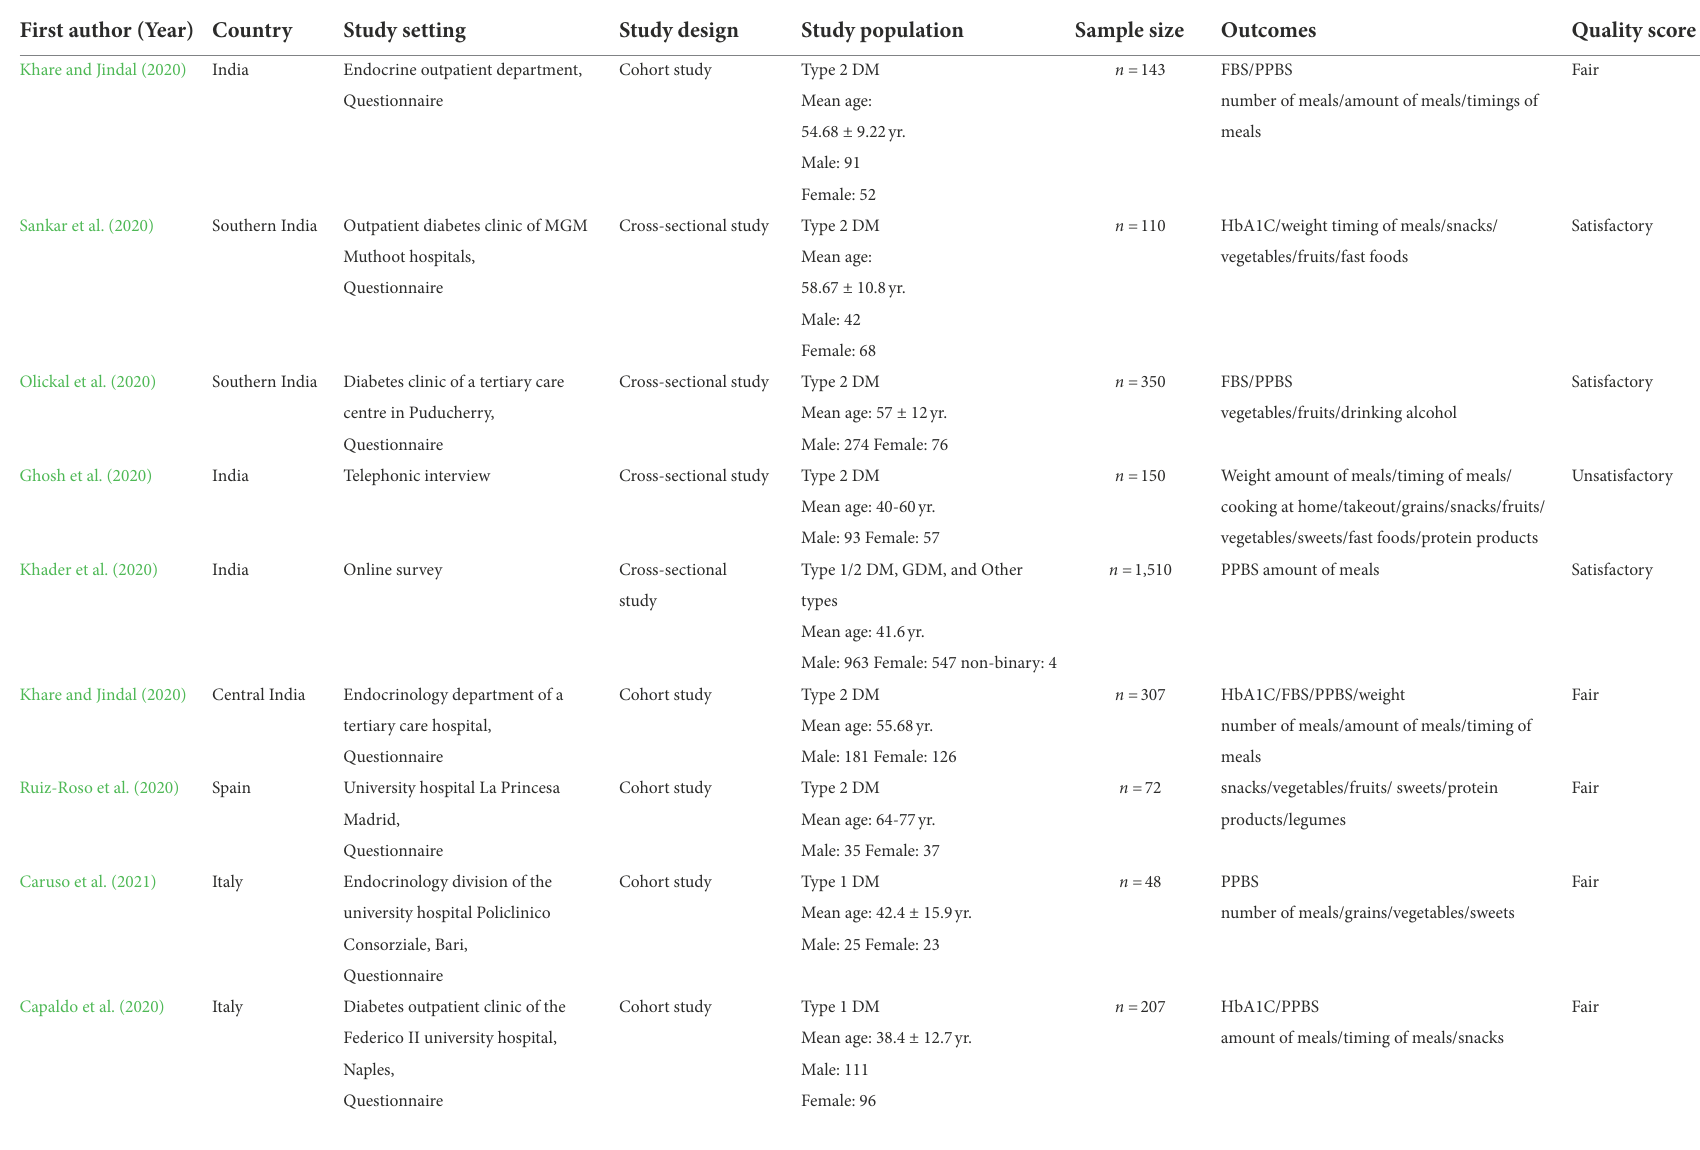
TABLE 1 General characteristics of included